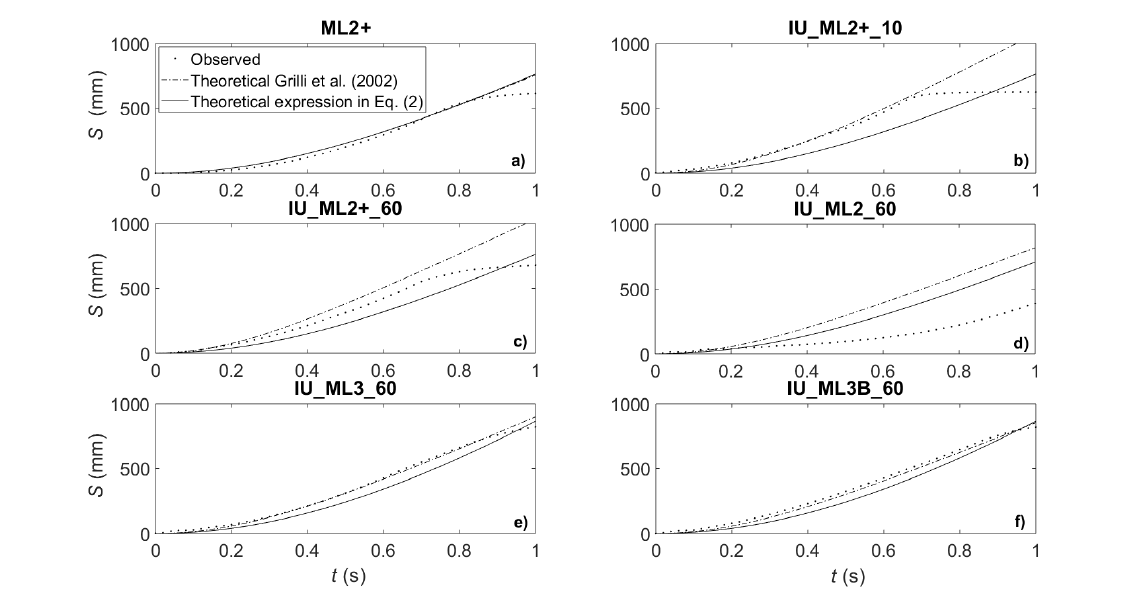
Figure 7. Observed data compared to theoretical approximations for landslide models ( a ) without and, ( b ) with an uplift of 10 mm, and ( c – f ) with an uplift of 60 mm in 370 mm water